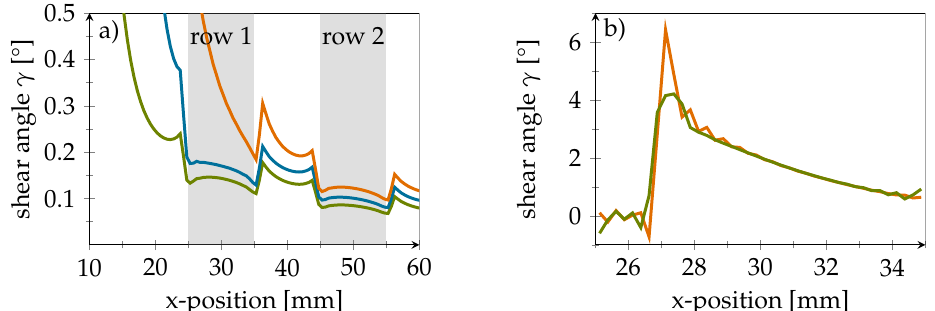
Figure 8. ( a ) Shear angle plot for different crack length. Green: 10 mm, Blue: 16 mm, Orange: 23 mm. Grey areas mark positions of PVDF inlays. ( b ) Difference in shear angle in xz-direction at the top and bottom of the PVDF inlay and a crack length of 27mm. Orange line represents PVDF-adhesive-interface while green line visualizes the PVDF-CFRP-interface.